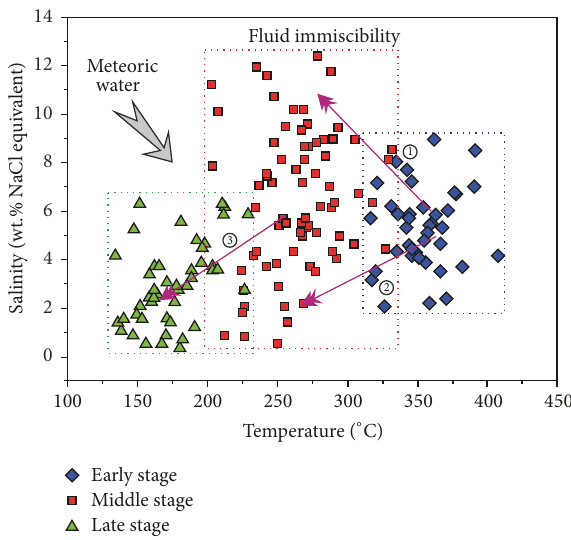
Figure 10: Salinity versus total homogenization temperature plot of the fluid inclusions, showing fluid evolution in the Liyuan gold deposit. Three purple arrows marked as A , B , and C represent the fluid evolution tendency from early to late stages. The arrows A and B mean that the FIs have wider salinities range from early to middle stage due to the fluid immiscibility. The arrow C represents that the temperature and salinities both decrease from middle to late